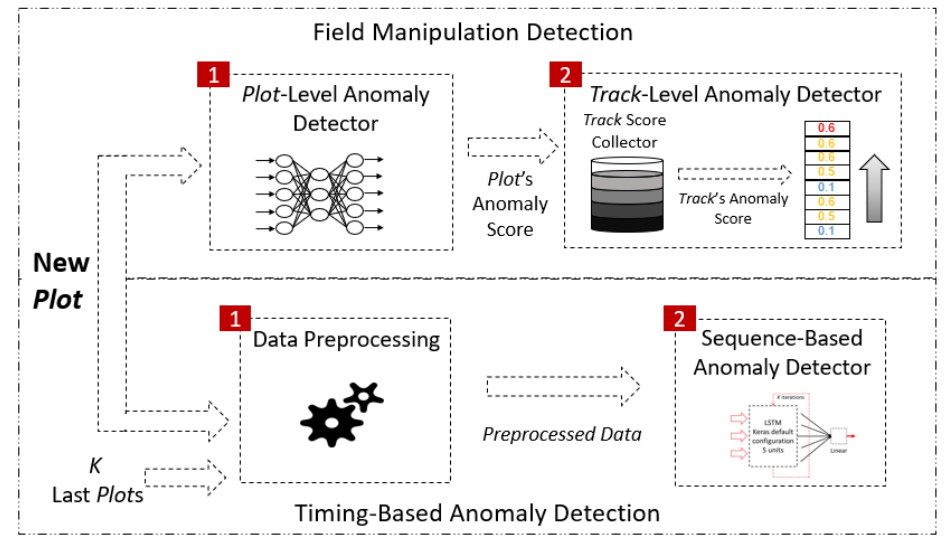
Figure 3. High-level architecture of the proposed anomaly detection method. Our method consists of two modules: a field manipulation-detection module and a timing-based anomaly-detection